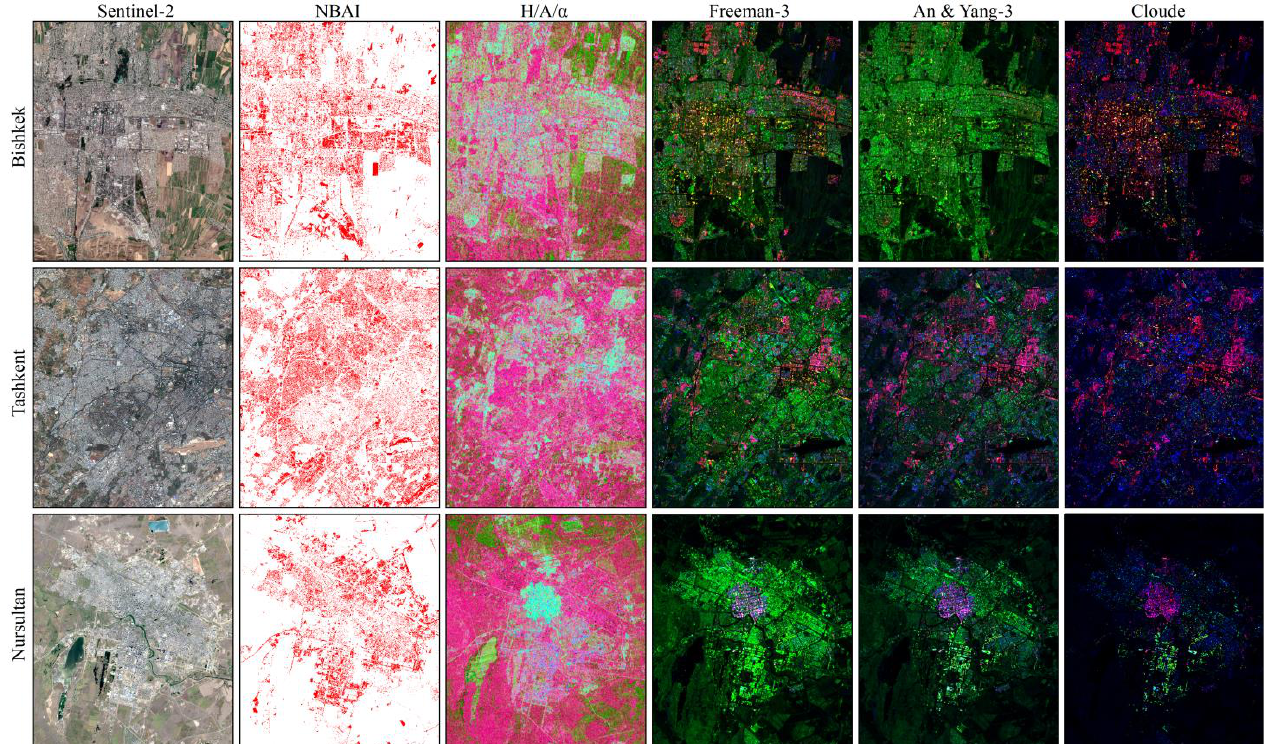
Figure 3. ISA extraction of NBAIs (red indicates ISA) and typical polarimetric decomposition comparison, RGB false color in H/A/α decomposition, Freeman -3 decomposition, An & Yang-3 decomposition and Cloude decomposition methods were, respectively, composited as: R (Entropy): G (Anisotropy): B (Alpha); R (Freeman_DBL): G (Freeman_VOL): B (Freeman_SURF); R (AnYang_DBL): G (AnYang_VOL): B (AnYang_SURF); and R (Cloude_T22): G (Cloude_T33): B (Cloude_T11).